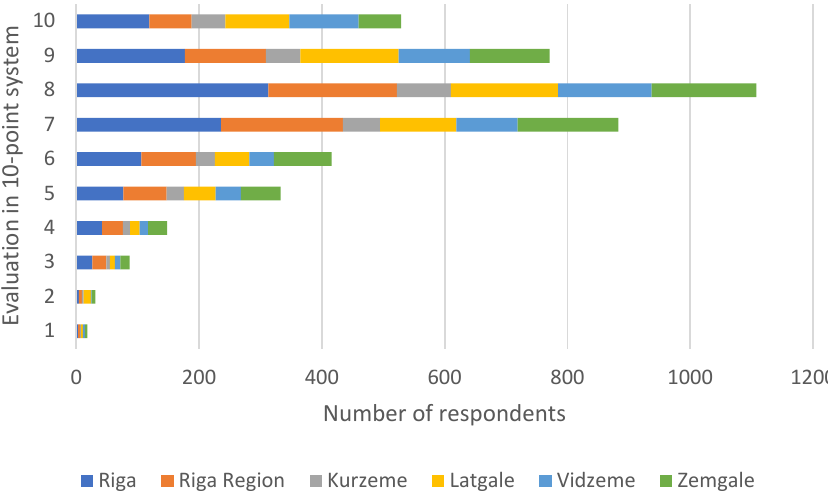
Figure 1. Parental evaluation of food packs in a line scale (10-point system) by regions of Latvia. Overall, 76% of parents rated food packs with 7 (good) and above. The largest percentage of respondents, comprising one-quarter of all respondents (1108), rated food packs with 8 (very good). Analyzing by regions, the largest percentage of respondents who rated food packs with 7 and above was in Vidzeme—81.7%, followed by Latgale— 79.4%, Riga—76.6%, Kurzeme—76.0 %, Riga region—73.1 %, and the lowest percentage of respondents was in Zemgale—71.3%. In total, the assessment was similar between re- gions. Food packs were given less than 4 points by 3% of respondents, who could not understand why food packs did not include local products. The obtained data allow the conclusion to be made that parents assessed the school catering allowance (food packs) implemented in Latvia as successful, albeit with some exceptions. 4. Discussion This study showed that the most popular school catering allowance during the pan- demic in all regions of Latvia was food packs, as they were considered to be the simplest, safest and easiest way of providing support to families with pupils. The provision of food packs was an effective tool in reducing the deterioration of eating habits of pupils, as re- search shows that there are social disparities between families during the COVID-19 pan- demic when the income of many families fell sharply [12]. Therefore, most parents appre- ciated this support, expressing their happiness with the received food products, but not- ing that the composition of food packs varied from school to school and that some food